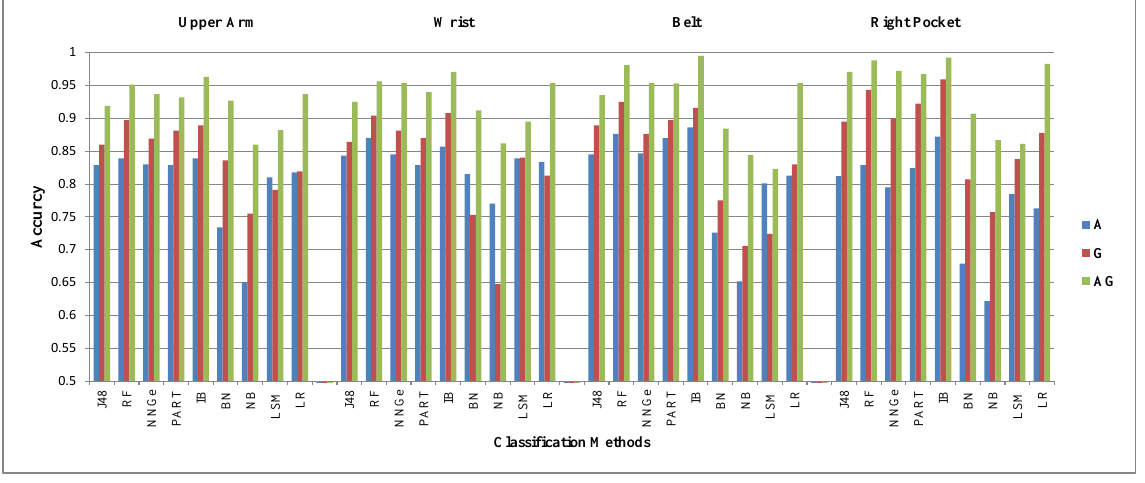
Figure 2. Recognition performance for the walking downstairs activity using FS2.